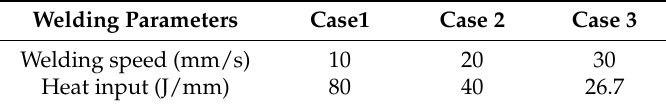
Table 5. Variation of heat input in this study.